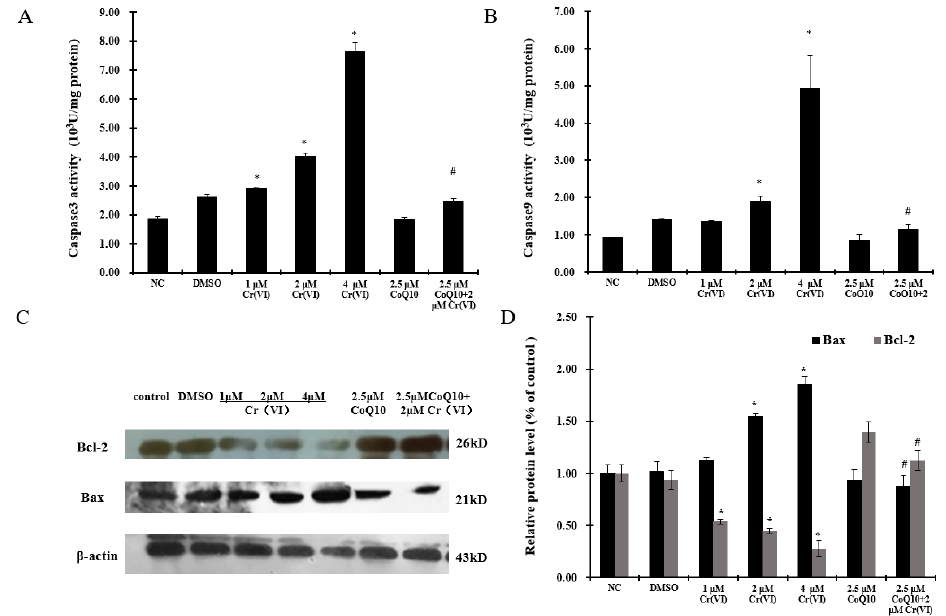
Figure 6. Cr(VI) induces caspase-3 and caspase-9 activation and unbalanced Bcl-2/Bax expression in response to apoptotic stimuli, and CoQ10 counteracts these outcomes. Cells were treated with Cr(VI) (0~4 μ M) for 24 h, with or without CoQ10 pretreatment for 2 h. Caspase-3 ( A ) and -9 ( B ) activities were detected using a microplate reader; ( C ) The expression of Bcl-2 and Bax was measured by Western blotting and the relative protein levels were calculated by Image J software ( D ). The data are expressed as mean ± SD ( n = 6). * p < 0.05 compared with the control group; # p < 0.05 compared with the 2 μ M Cr(VI) treatment group.